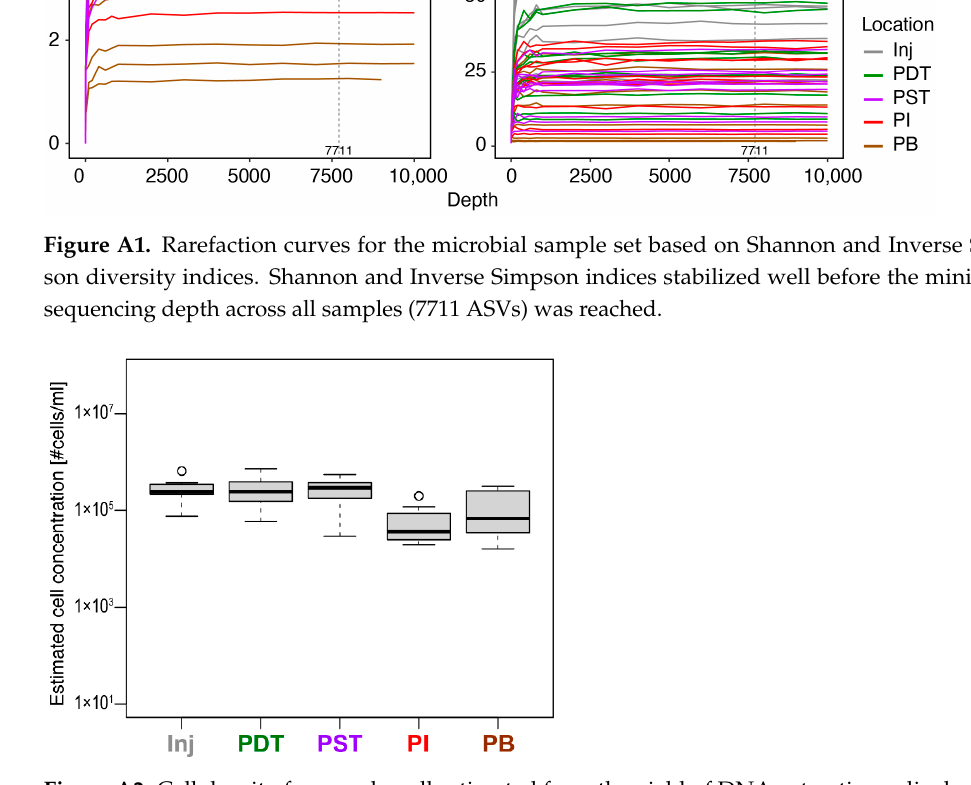
Figure A2. Cell density from each well estimated from the yield of DNA extractions, displayed as box (and whisker) plots. The thick black horizontal line within each box denotes the median of the distribution of the 10 samples from each well. The bounds of the y-axis were selected based on previously observed cell concentration values in continental subsurface fluids [11].